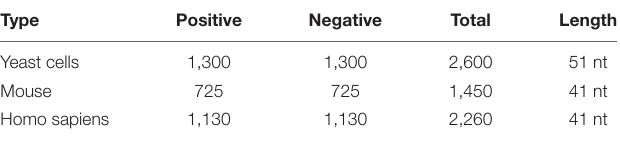
TABLE 1 | Details of benchmark